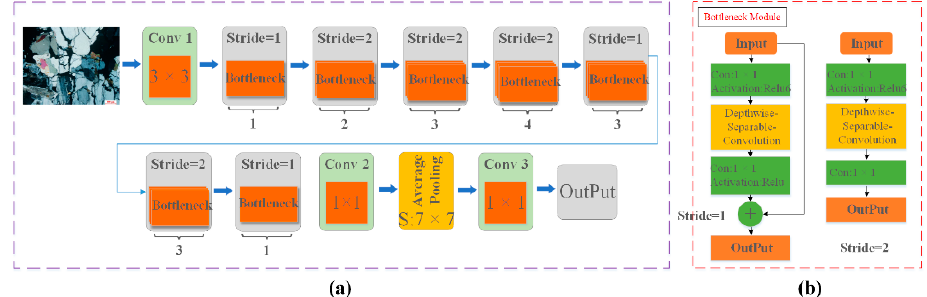
Figure 6. Network structure. ( a ) MobileNetV2 architecture; ( b ) bottleneck module structure.